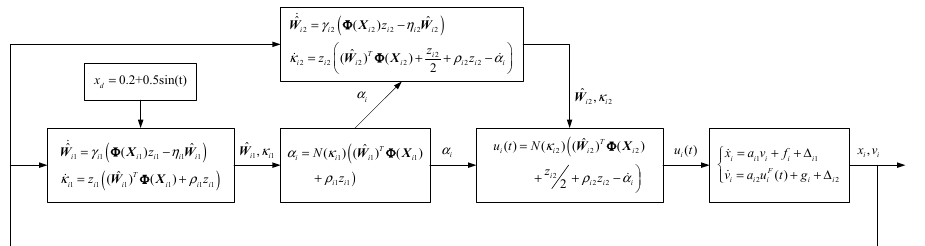
Figure 1. Block diagram of the control system.